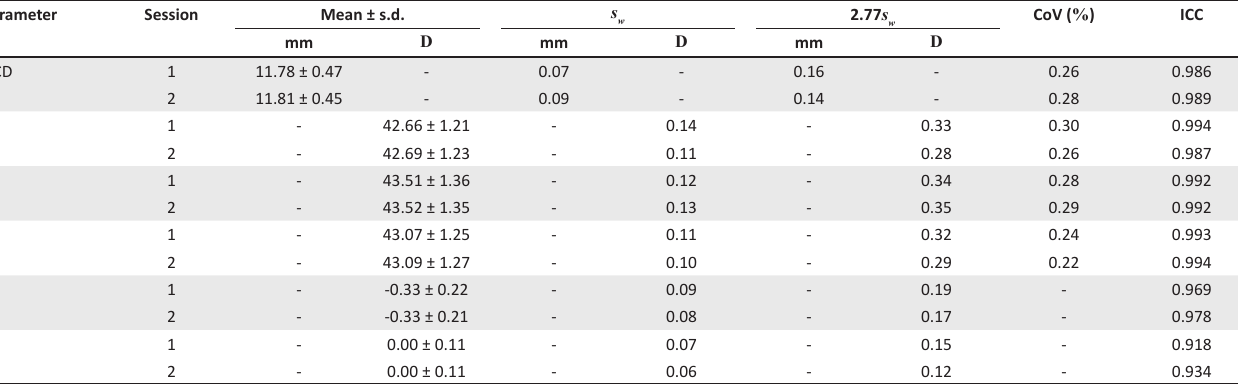
and J using the Oculus Keratograph 4. 0 45